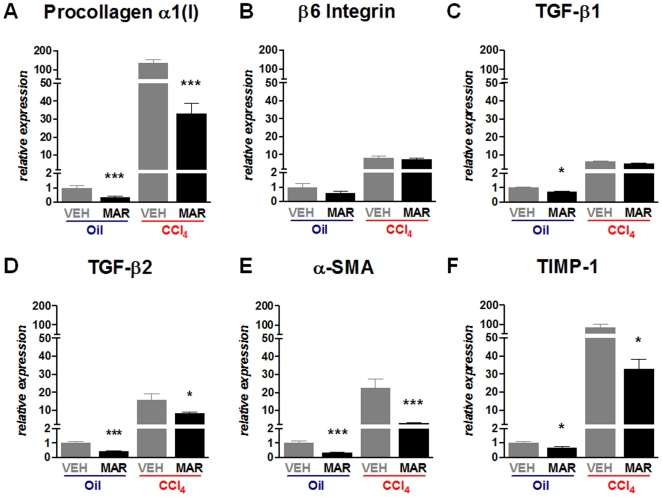
Marimastat altered the hepatic fibrosis-related gene expression profile by downregulation of multiple pro-fibrogenic transcripts following repeated carbon tetrachloride (CCl4) administration.Hepatic procollagen α1(I) (A), β6 integrin (B), TGF-β1 (C), TGF-β2 (D), α-SMA (E) and TIMP-1 (F) expression as quantified by real-time RT-PCR in total liver RNA. Oil, non-fibrotic control group; CCl4, fibrotic mice; VEH, vehicle treated control group; MAR, Marimastat treated experimental group; TGF, transforming growth factor; SMA, smooth muscle actin; TIMP, tissue inhibitor of metalloproteinases; *, P<0.05; ***, P<0.001 vs. vehicle alone. Data are expressed as means ± standard error and in arbitrary units relative to non-fibrotic vehicle treated control.